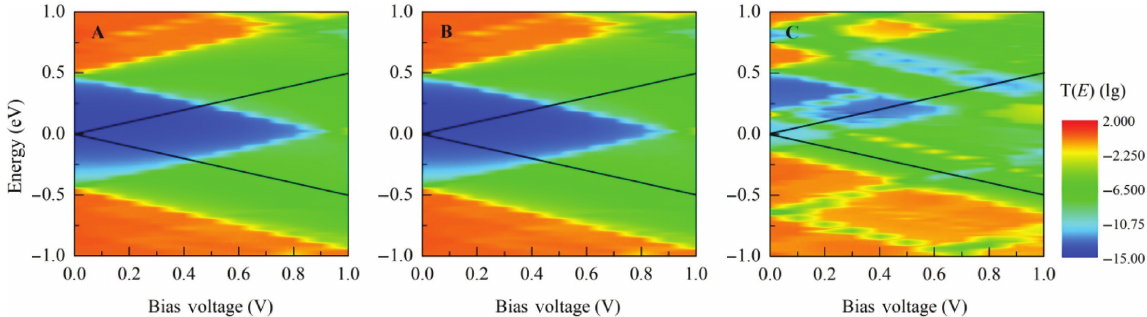
Figure 5: The dependence of transmission coefficient on bias voltage and photon energy. Contour maps of transmission coefficient (lg) as a function of energy varying from −0.5 to 0.5 eV and bias voltage of 0–1.0 V in the (A) covalent bond 1-, (B) close-packed nonbond 2-, and (C) nonbond 3-directions of bilayer tellurene photodetector. The area enclosed by black lines is the region of bias window.